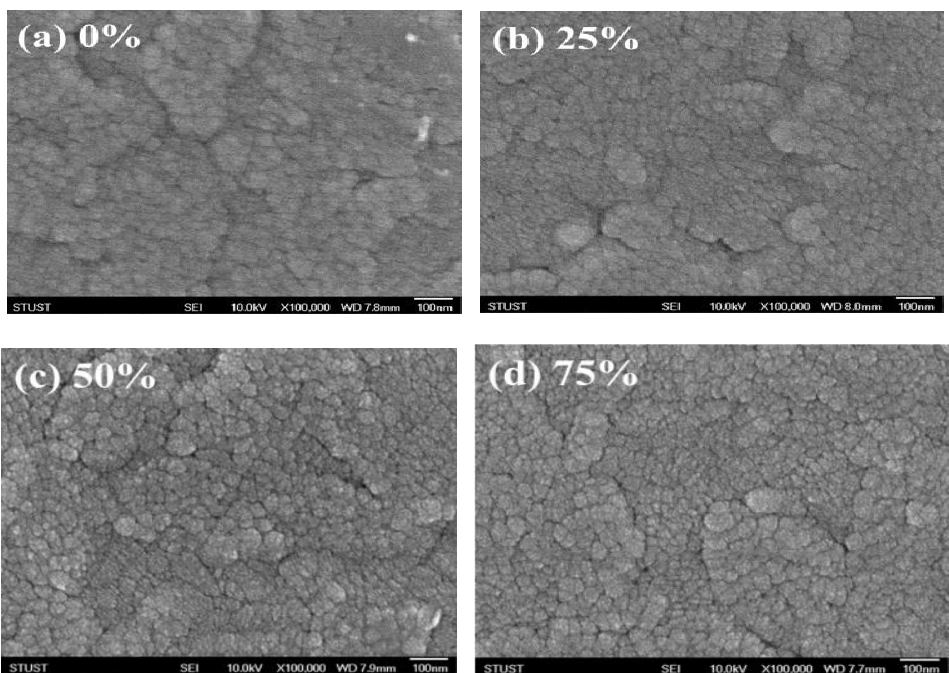
Figure 5. The surface micro-structure images of ITO X thin films prepared by different oxygen growth procedure parameters for ( a ) 0%, ( b ) 25%, ( c ) 50%, and ( d ) 75%.